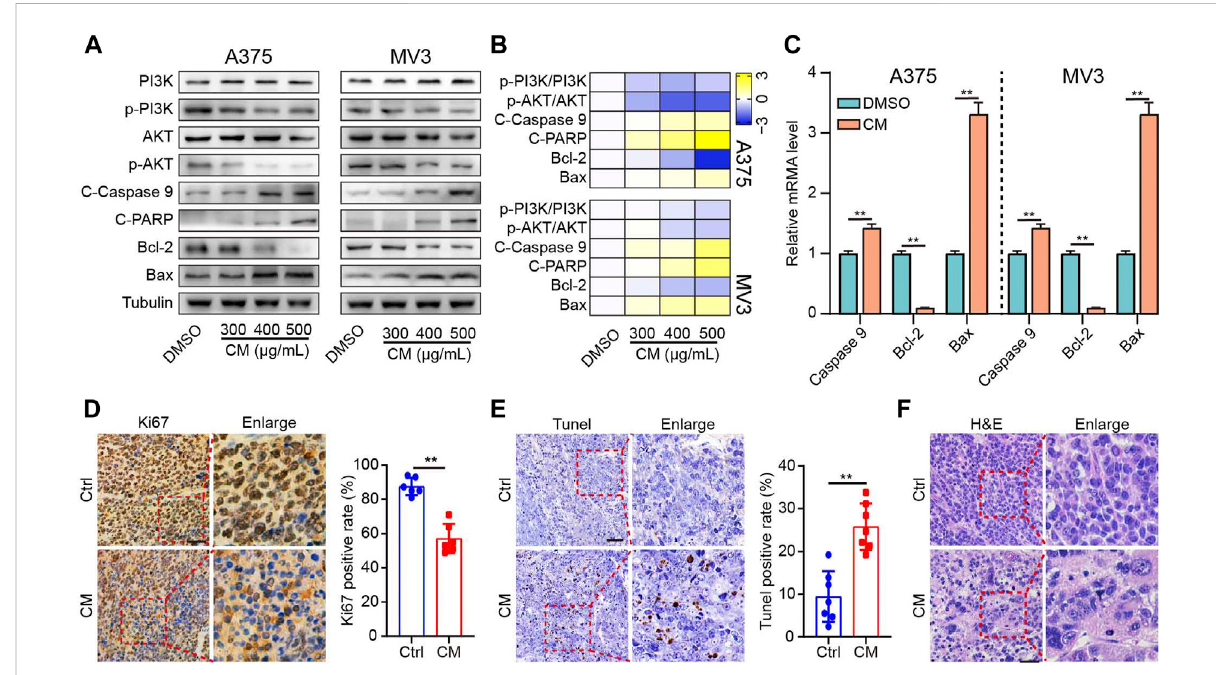
FIGURE 5 CM inhibits the growth by inducing apoptosis of melanoma cells and inhibiting the PI3K/AKT pathway. (A) The western blotting was performed on the A375 (left) and MV3 cells (right) against PI3K, p-PI3K, AKT, p-AKT, cleaved Caspase 9 (C-Caspase 9), cleaved PARP (C-PARP), Bcl- 2, and Bax. (B) Heat map visualization of Log 2 [relative protein level] in panel (A) . (C) CM affected mRNA expression of Caspase 9, Bcl2, and Bax in A375 and MV3 cells analyzed by quantitative RT-PCR. (D) Ki67 immunohistochemistry staining in tumor sections and the percent of Ki67 positive cells were calculated as the fraction of Ki67 positive cells compared to the total number of cells. (E) The effect of CTFs on apoptosis of tumor tissue by TUNEL. (F) Histopathological examination of H&E staining in tumor sections. The asterisks indicate statistically signi fi cant differences (* p < 0.05 and ** p < 0.01). Ctrl: control. CM: Cortex Mori